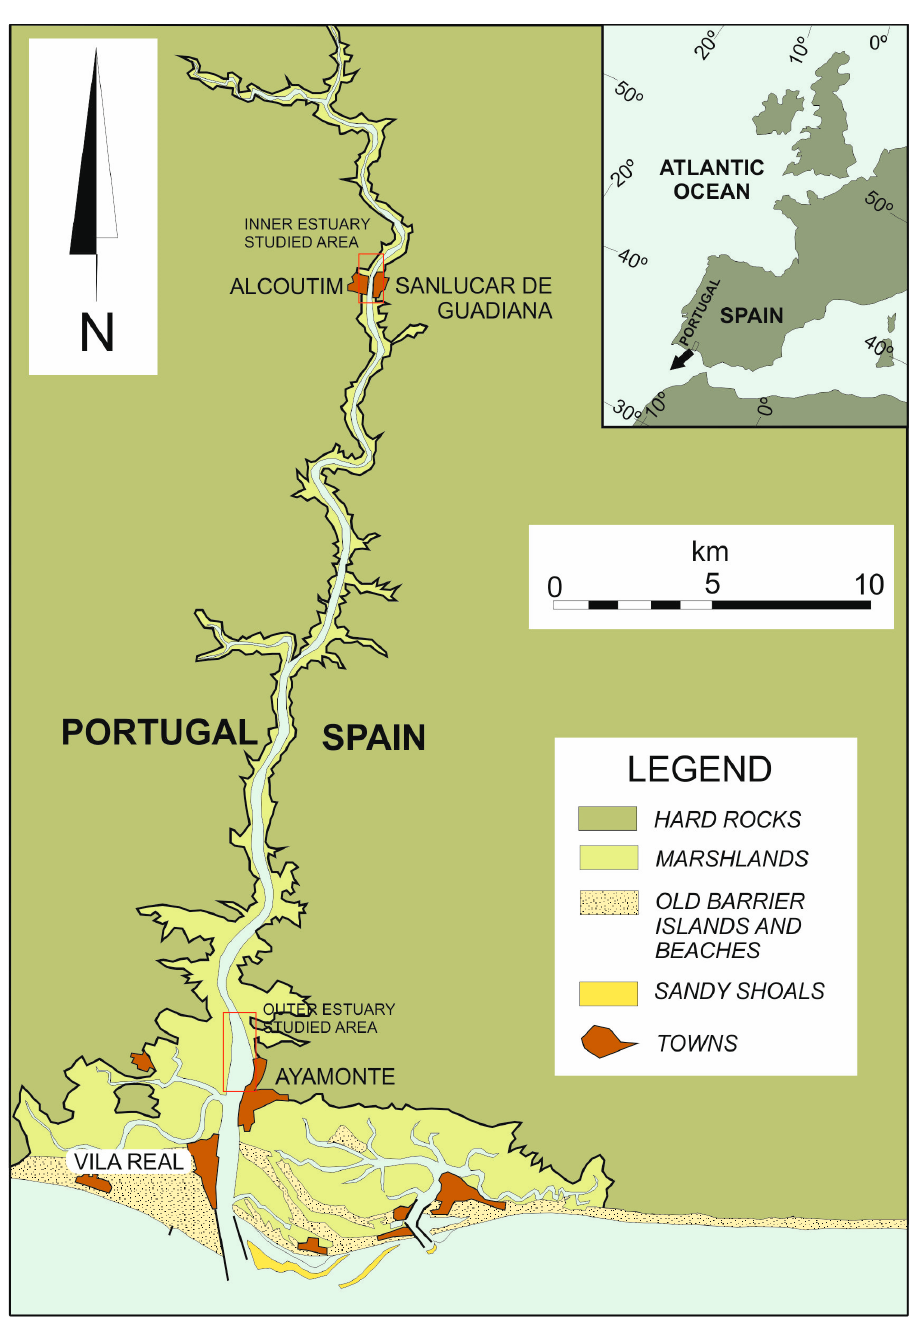
Figure 1. Location of the studied sections on the inner and outer sectors of the Guadiana Estuary.